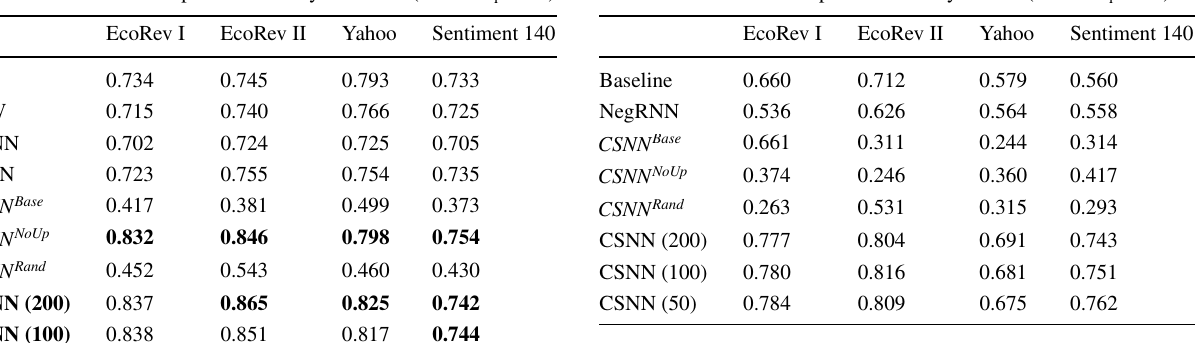
Table 3 Evaluation for explanation ability in WOSL (Macro F 1 score)